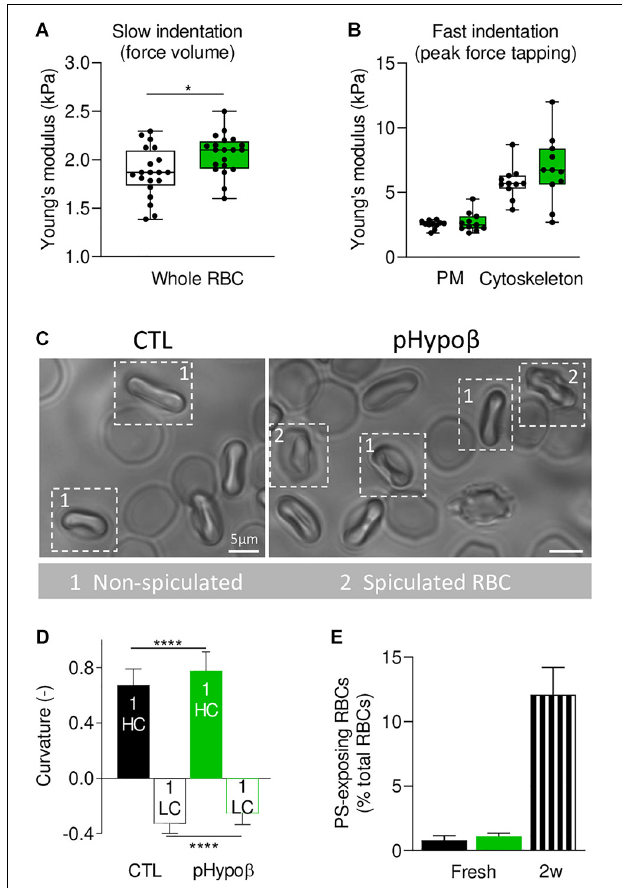
FIGURE 7 | Membrane stiffness and curvature are increased in pHypo β RBCs whereas membrane transversal asymmetry is not modified. RBCs from healthy donors (CTL, black) or pHypo β (green) were evaluated for membrane stiffness (A,B) , curvature (C,D) and transversal asymmetry (E) . (A,B) Membrane stiffness. (A) Young’s modulus values extracted for CTL and pHypo β RBCs in Slow indentation experiments, where the whole RBC mechanical behavior was analyzed. (B) Young’s modulus of CTL and pHypo β RBCs obtained in Fast indentation experiments, where the elastic contribution of the plasma membrane (PM) and cytoskeleton were evaluated separately. Each data point represents the mean Young’s modulus value calculated for one RBC. Box plots depict 25th–75th percentiles, horizontal lines and cantered squares show mean values and error bars indicate SD. 20 RBCs were analyzed in (A) and 11 RBCs in (B) . Two-sample t -test. * p < 0.05. (C,D) Membrane curvature. RBCs were diluted, dropped off in IBIDI chambers and immediately observed by microscopy. Spiculated RBCs (indicated by 2) were distinguished from non-spiculated RBCs (indicated by 1) and the latter were then quantified for curvature in high curvature maxima (HC) and low curvature maxima (LC). 110 RBCs were analyzed for healthy donors and 50 RBCs for pHypo β . Two-sample t -test. **** p < 0.0001. (E) Membrane transversal asymmetry. RBCs were labeled with fluorescent Annexin-V and then